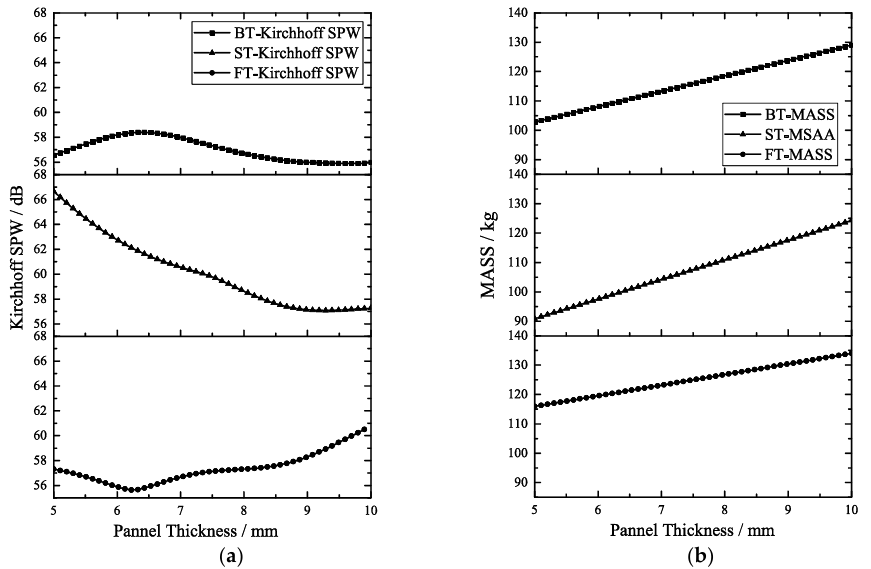
Figure 25. The relationship profile between each panel thickness and objective function (the Kirchhoff SPW or the total mass of the volute). ( a ) The relationship of volute panel thickness and Kirchhoff SPW. ( b ) The relationship of volute panel thickness and total mass.